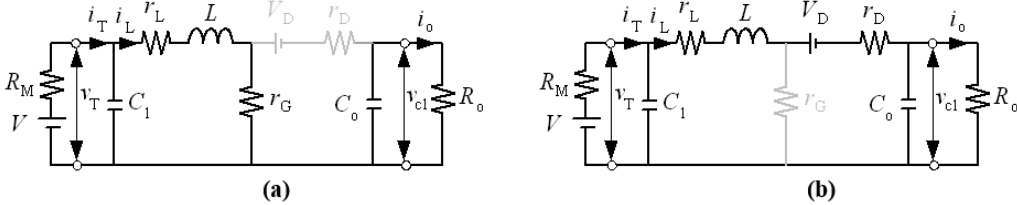
Figure 6. Configuration on modeling of power generation system. C 1 : Linking capacitor; C 0 : Output